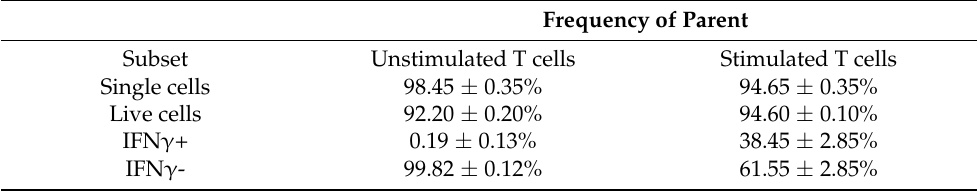
Table 2. Comparison of pro-inflammatory cytokine secretion between T cell populations 1